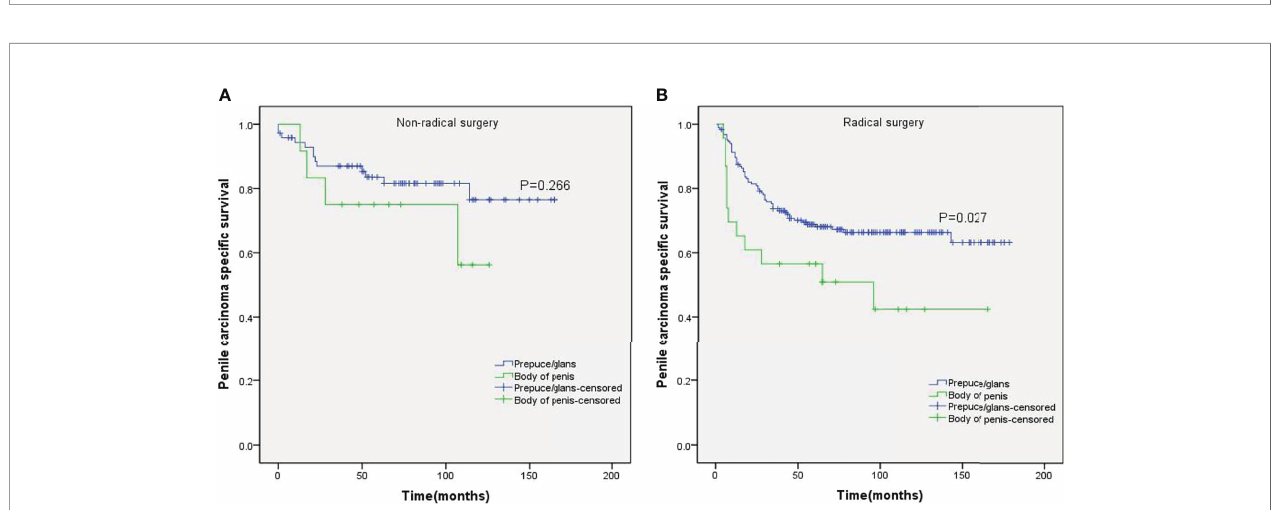
FIGURE 7 | Kaplan – Meier analyses of penile carcinoma-speci fi c survival in non-radical surgery group (A) and radical surgery group (B) in patients strati fi ed by tumor